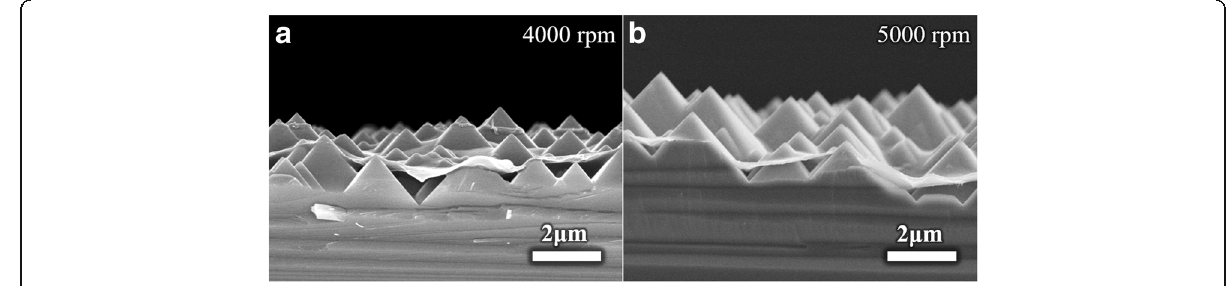
Fig. 5 The cross-sectional view of textured Si coated PEDOT:PSS film ( a ) with 4000 rpm and ( b ) with 5000